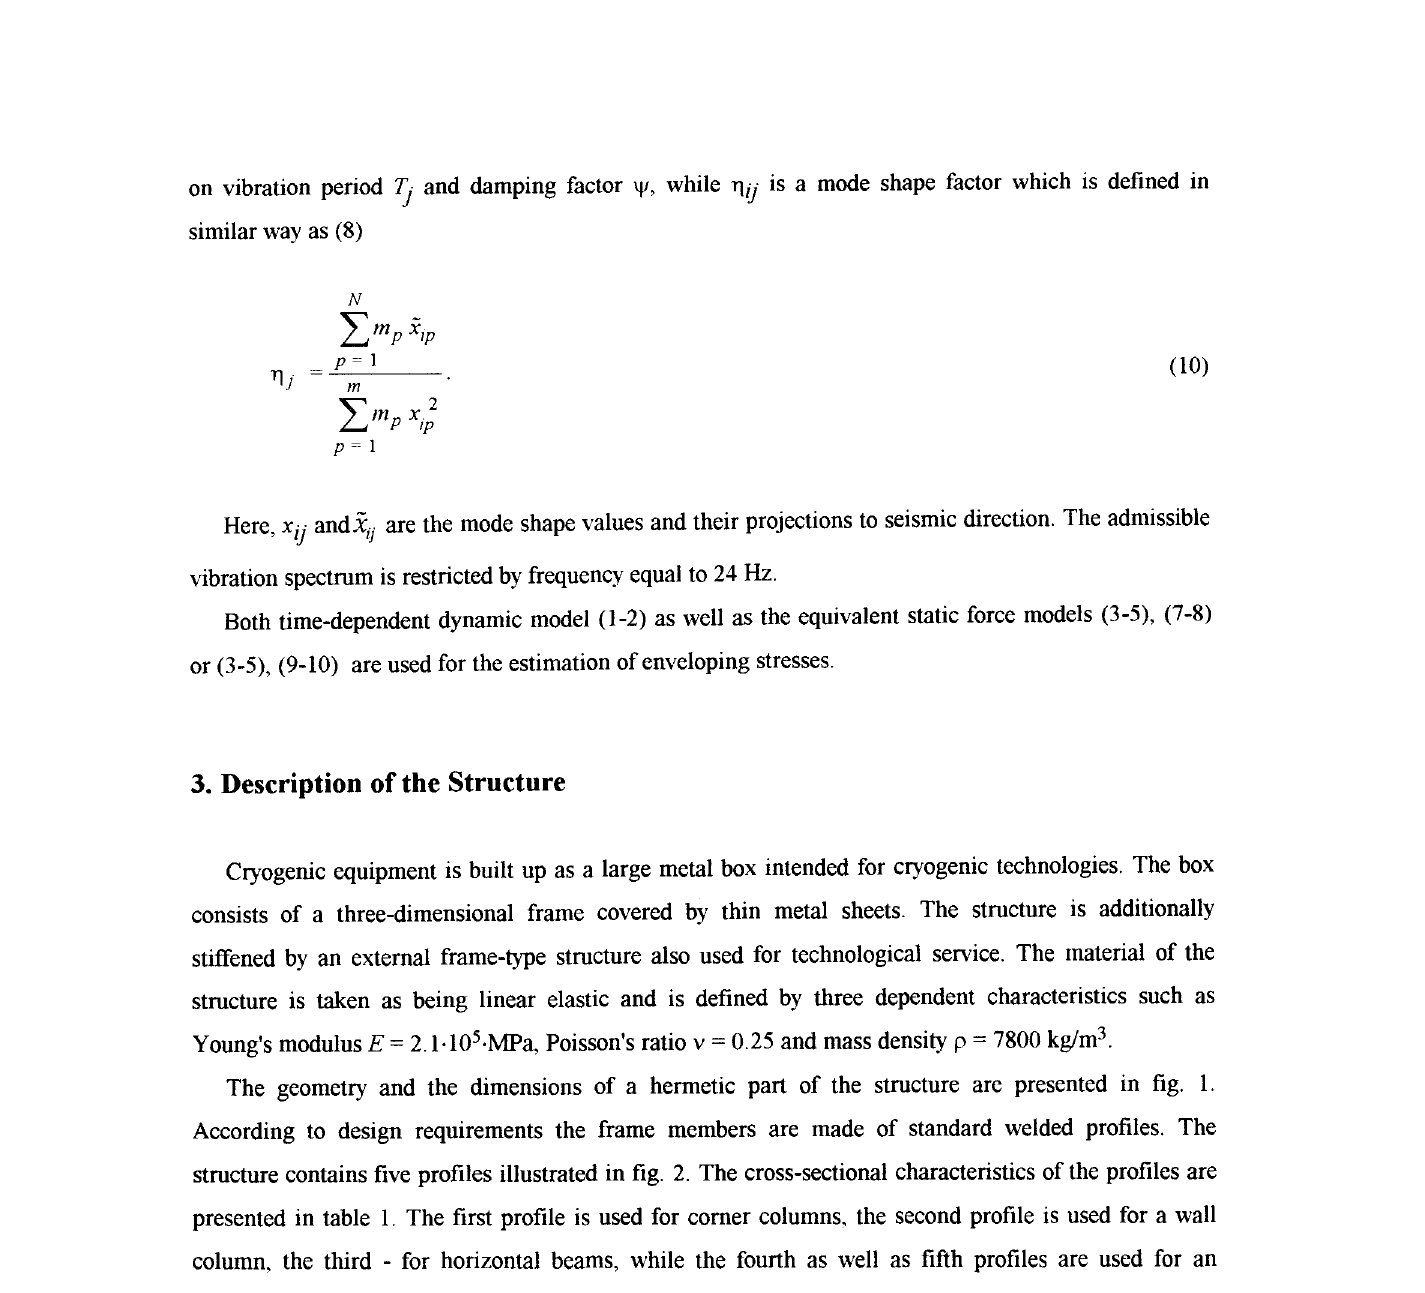
Table l. Geometric characteristics of